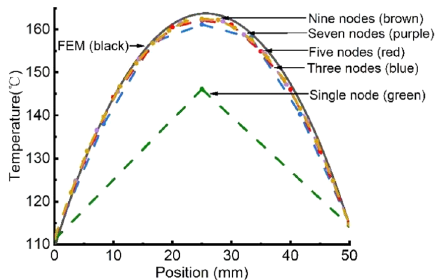
Figure 5. Temperature distribution of the GMM rod in FEM and thermal network model with different complexity.